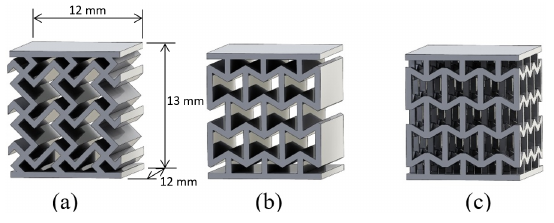
Figure 9. Tested auxetic structures, (a) 2D cut missing-rib, (b) 2D inverted honeycomb, (3) 3D in- verted honeycomb.